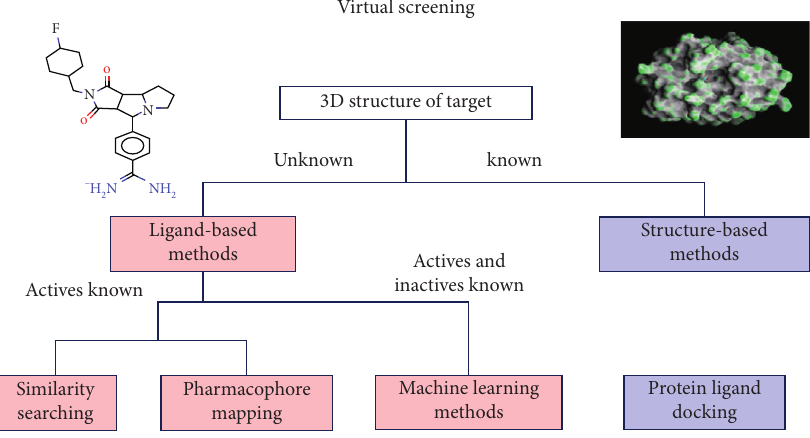
Figure 1: Taxonomy for the 3D structure of VS methods